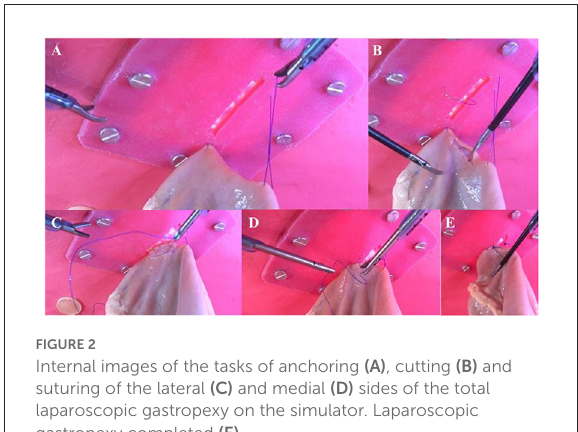
FIGURE2 Internal images of the tasks of anchoring (A) , cutting (B) and suturing of the lateral (C) and medial (D) sides of the total laparoscopic gastropexy on the simulator. Laparoscopic gastropexy completed (E)